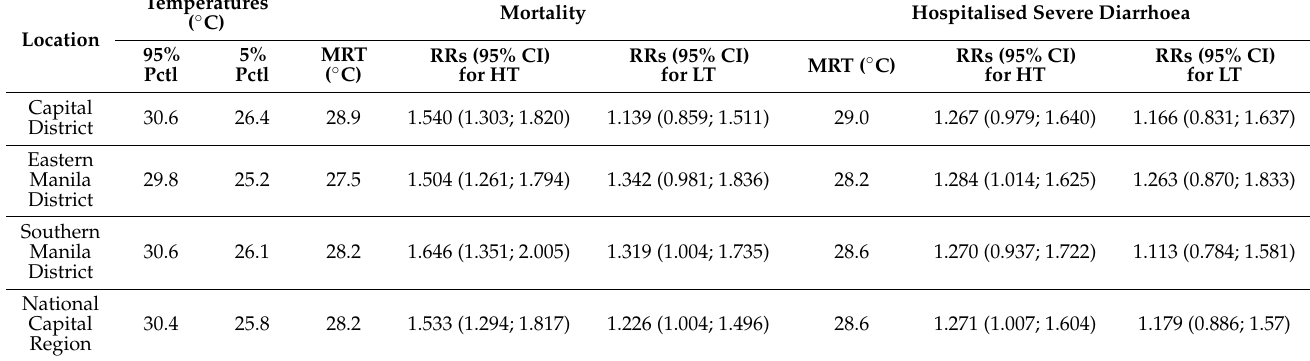
Table 2. Relative risks (RR) and 95% confidence intervals (CI) for the association of severe diarrhoea with high temperatures (HT) and low temperatures (LT) relative to the minimum risk temperatures (MRT) in the National Capital Region of the Philippines in